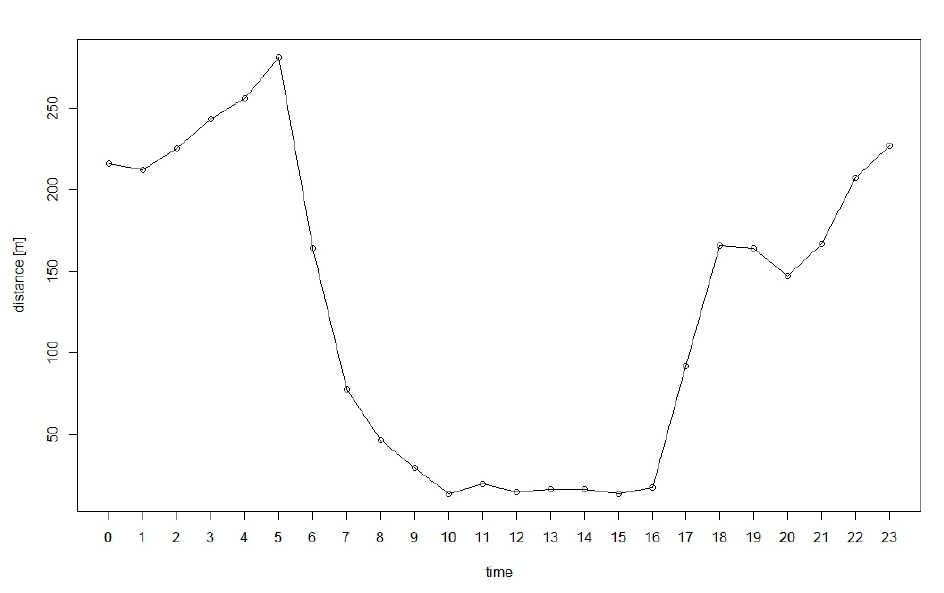
Figure 4. Mean distance (m) travelled hourly of the two bears during day and night in the hyper- phagic period. Time shows the hours of the